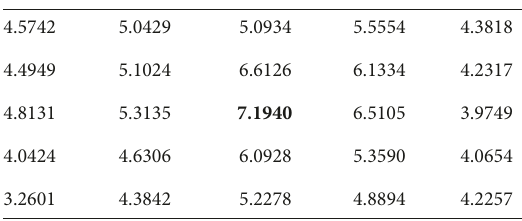
) with its overlap patches entropies. new